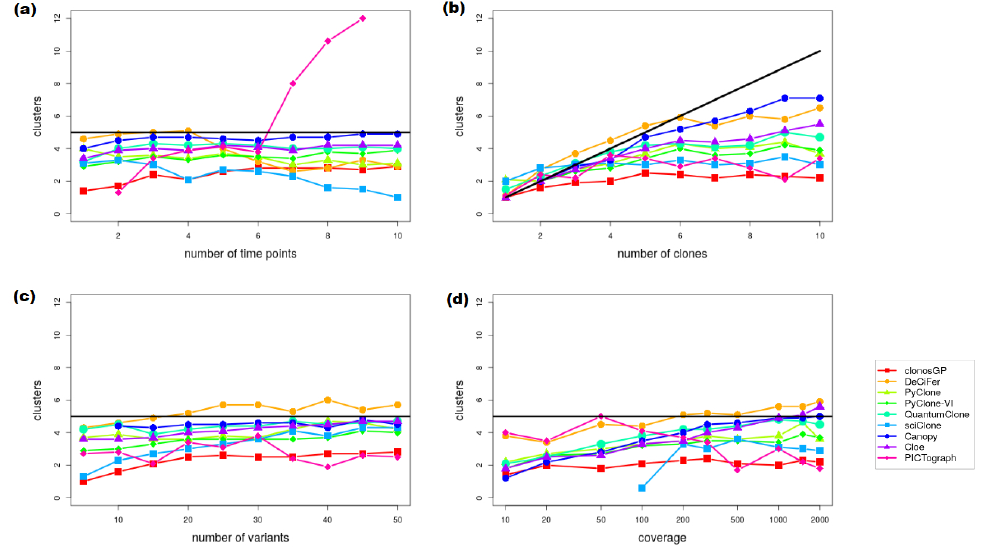
Figure A10. Number of clusters reported using clonosGP, DeCiFer, PyClone, PyClone-VI, Quantum- Clone, sciClone, Canopy, Cloe, and PICTograph in the absence of CNVs for varying numbers of ( a ) time points, ( b ) clones, ( c ) variants, and ( d ) coverage. The black line indicates the true number of simulated